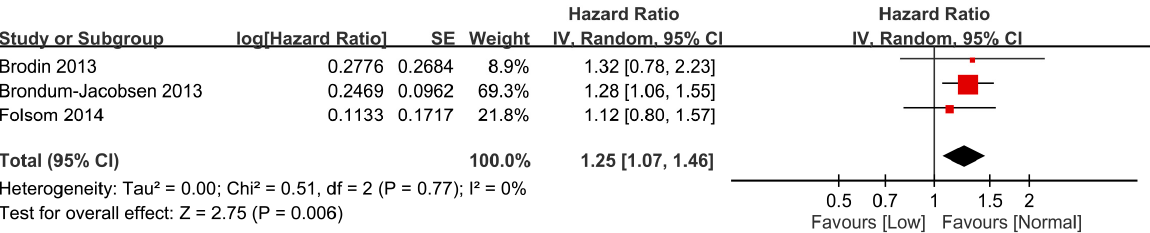
Figure 3. Funnel plot showing a low risk of publication bias.